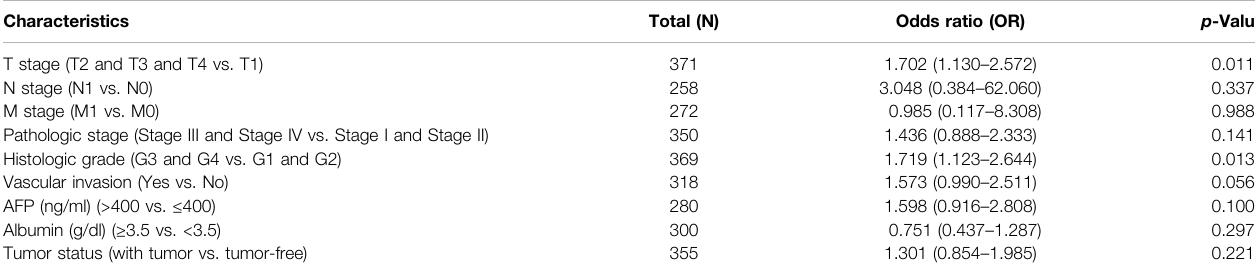
TABLE 3 | DDOST expression correlated with clinicopathological characteristics analyzed by logistic regression. Characteristics Total (N) Odds ratio (OR) p -Value T stage (T2 and T3 and T4 vs.